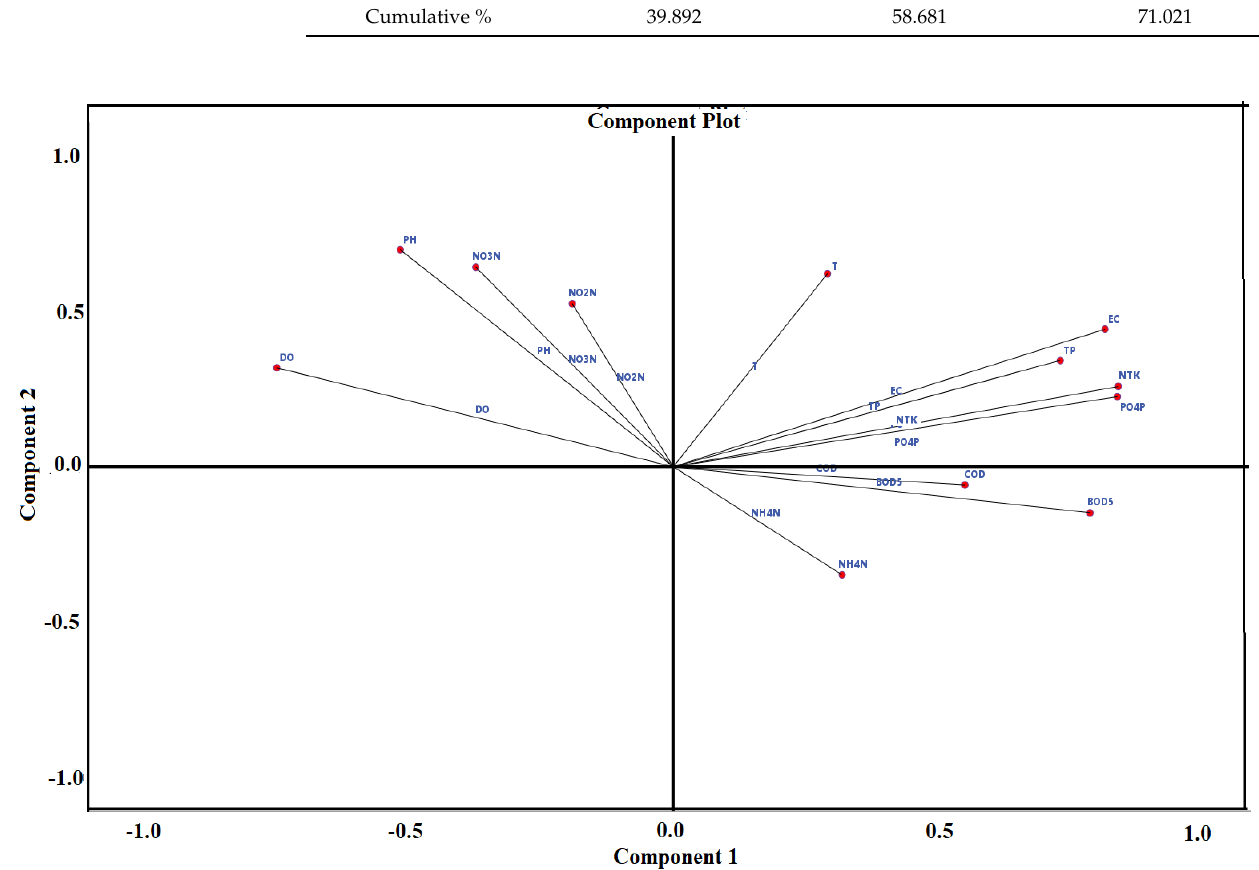
Figure 3. Physicochemical parameter score. Table 6. Eigenvalues on the correlation matrices of the concentration of the physicochemical param- eters, in %.